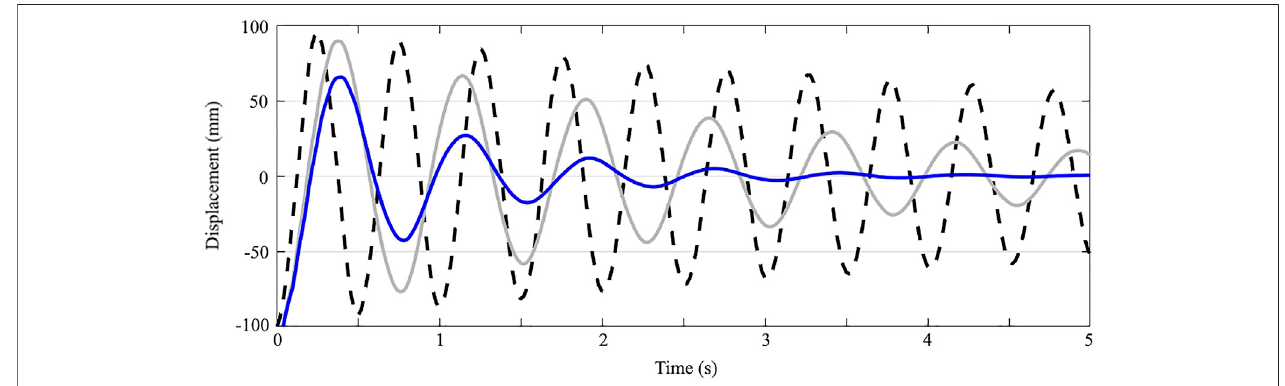
Frontiers in Built Environment |